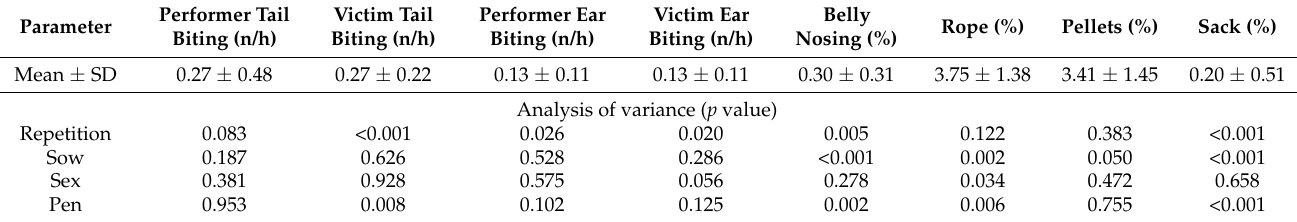
Table 6. Average manipulation behavior during rearing, frequency 1 or percentage 2 per pig and